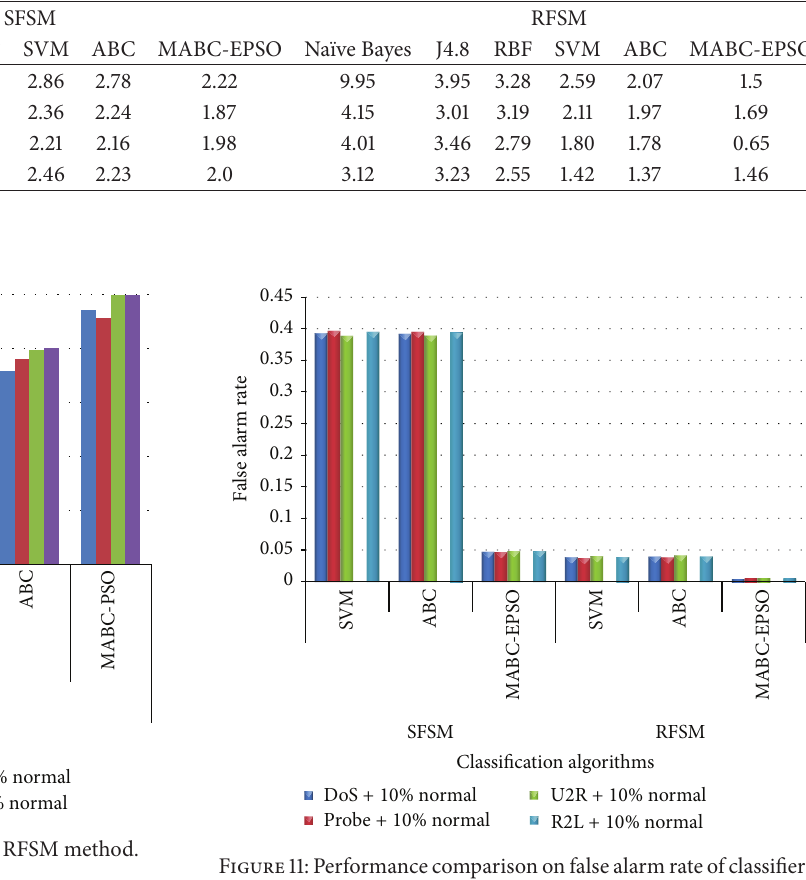
Figure 11: Performance comparison on false alarm rate of